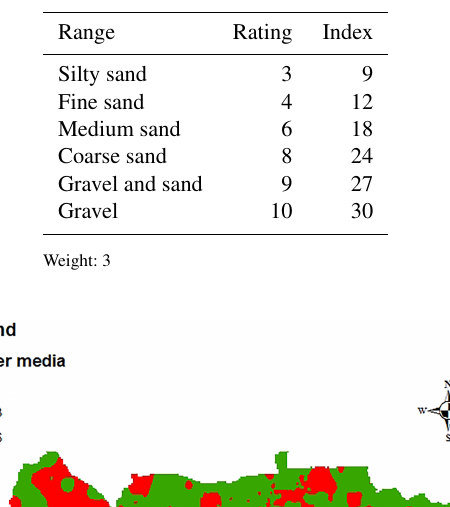
Table 3. Range and rating for aquifer media.